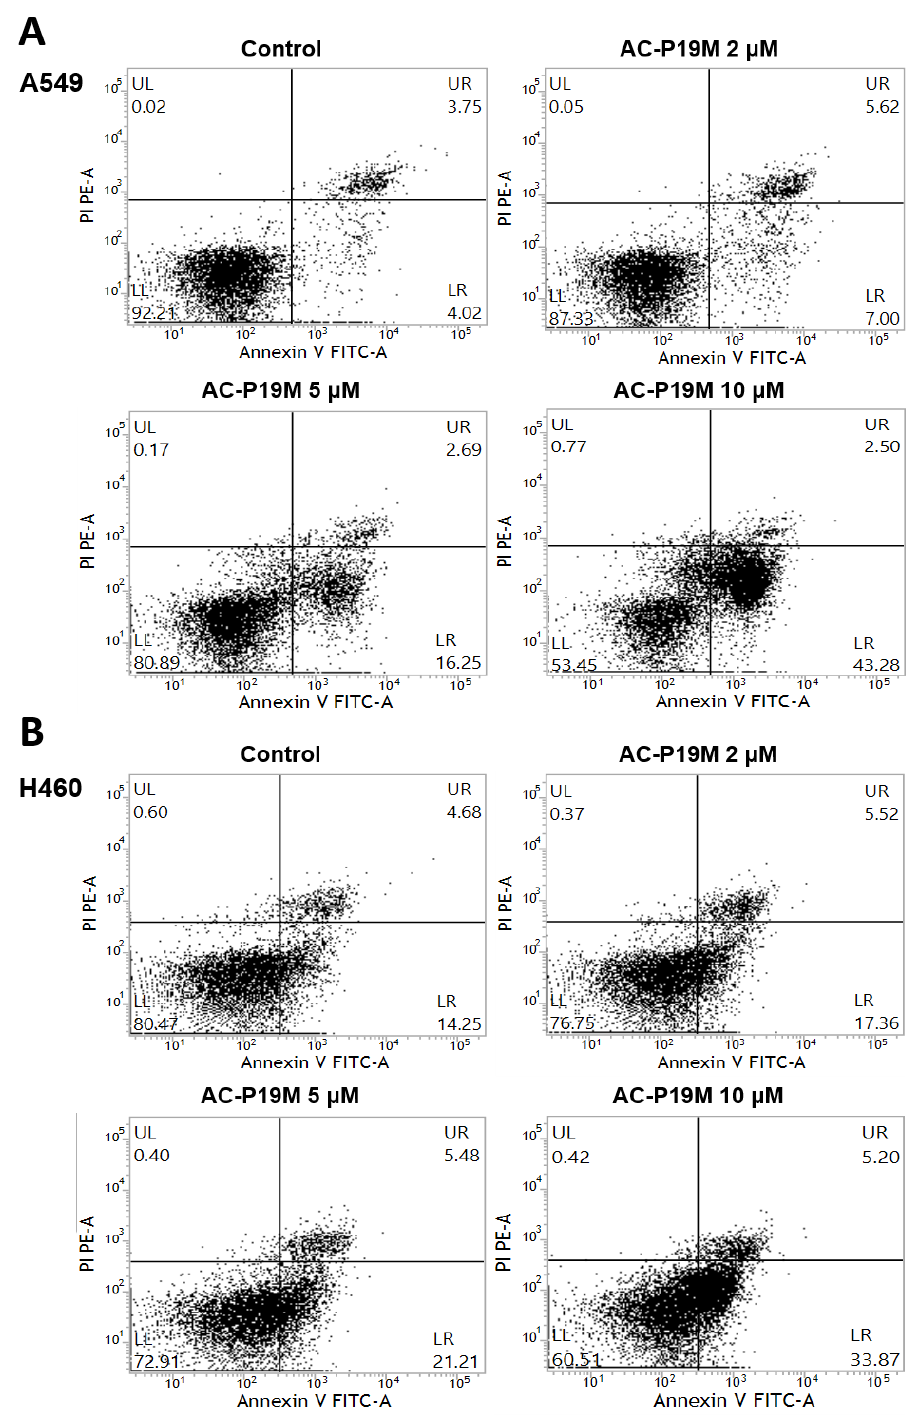
Figure 3. Apoptosis induction by AC-P19M in lung cancer cells. Apoptosis in ( A ) A549 and ( B ) H460 cells upon AC-P19M treatment was evaluated by flow cytometry analysis through Annexin V-FITC and PI double staining (UL: upper left, UR: upper right, LL: lower left, LR: lower right). The analysis was performed by comparing the control (PBS-treated) and the peptide treatment groups (2, 5, 10 µ M of AC-P19M). The numbers of both early (Annexin V-FITC+ single positive) and late (Annexin V-FITC/PI double positive) apoptotic cells increased with increasing peptide concentration. The representative images of duplicate samples for the apoptosis assay were shown.